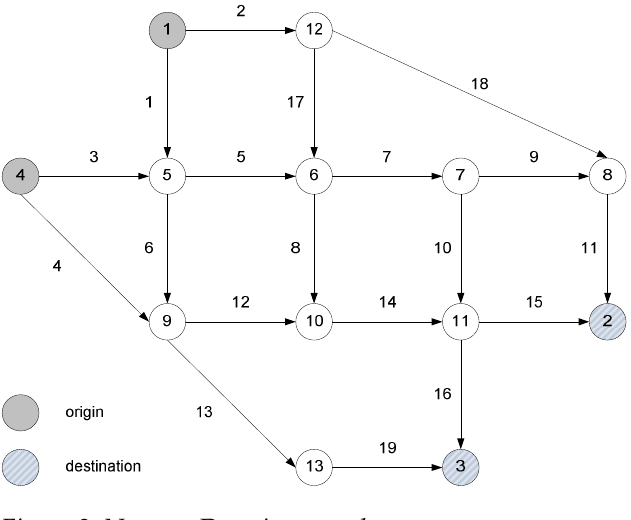
Figure 3. Nguyen-Dupuis network Table 6. Link-path incidence relationship for the example network OD